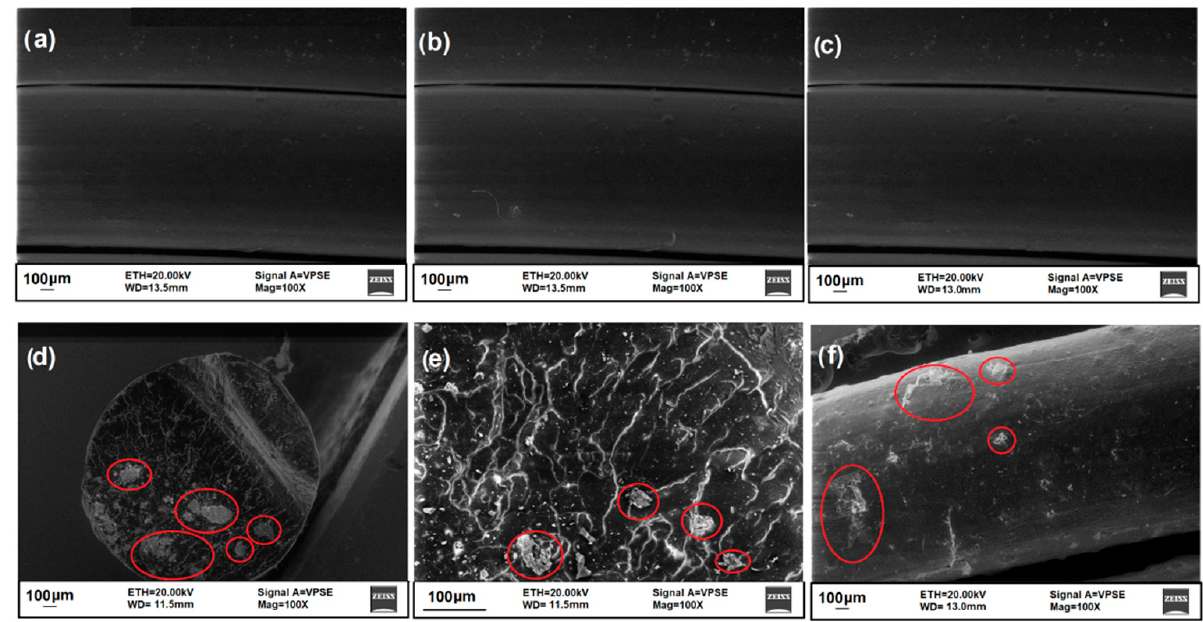
Figure 4. SEM images of: ( a ) DF filament (100X); ( b ) AF filament (100X); ( c ) BF filament (100X); ( d ) section of filament CF (100X); ( e ) section of filament CF (500X); ( f ) CF filament (100X). XRD spectra acquired on the filaments detect a significant decrease of the intensity of diffraction peaks (Figure 2g–i). The polymer filaments (AF, BF) show an amorphous band (Figure 2g,h), while in the CF filament, few ceramic powder diffraction peaks remain above the main amorphous band (Figure 2i). Main peaks are located at 2 θ ( ◦ ) equal to 26.35 ◦ , 27.67 ◦ , and 31.07 ◦ , respectively. More precise information on the crystallinity of extruded filaments was acquired from DSC analysis. Figure 3b shows the DSC thermograms obtained from the analysis of the different filaments produced, compared with the commercial filament DF. Moreover, by calculating melting and crystallization enthalpies, it was